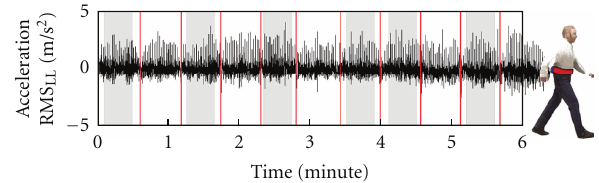
Figure 1: The acceleration signal along laterolateral direction of a patient. The grey large bands highlight the analysed part of the signal for each one of the 6 minutes of the test. The thin red lines indicate the end of each 20m